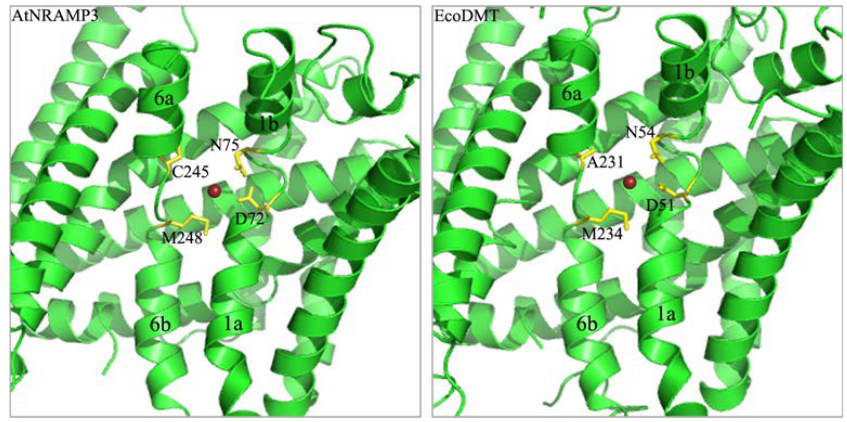
Figure 7. Putative ion-binding site of AtNRAMP3. Comparison of the putative ion-binding site of AtNRAMP3 ( left ) with characterized ion-binding sites of EcoDMT ( right ). The putative ion-binding site and homology model of AtNRAMP3 was based on the known ion-binding site and crystal structure of EcoDMT. The active ion-binding site of AtMRANP3 was conserved with ion-binding site of EcoDMT.